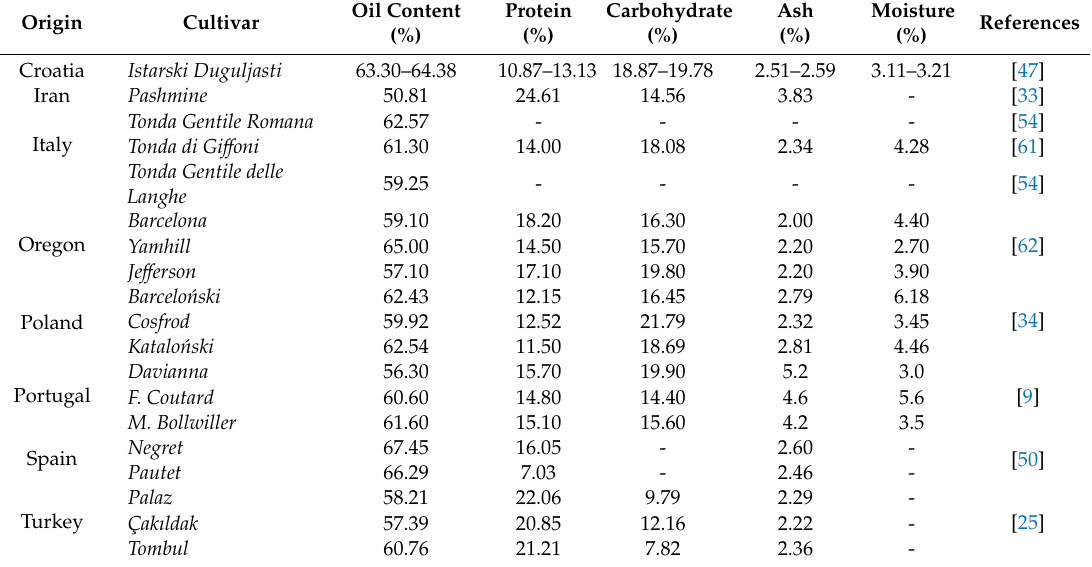
Table 2. Chemical composition of hazelnut cultivars from a di ff erent